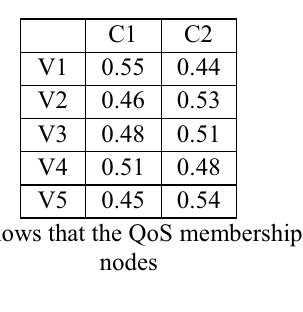
Table: 6 contains the values membership function of the sensor nodes